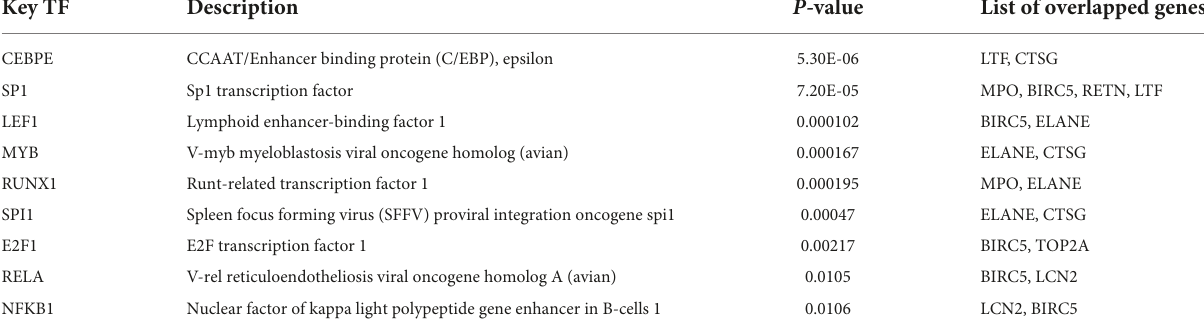
TABLE 7 Key transcriptional factors (TFs) of hub